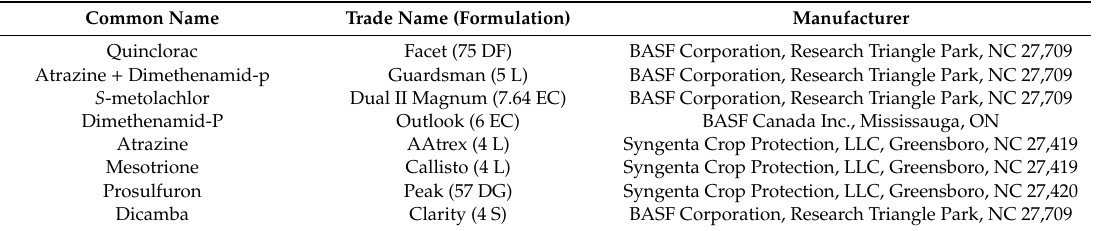
Table 2. Herbicide treatments used in this study, their trade names, and manufacturers.